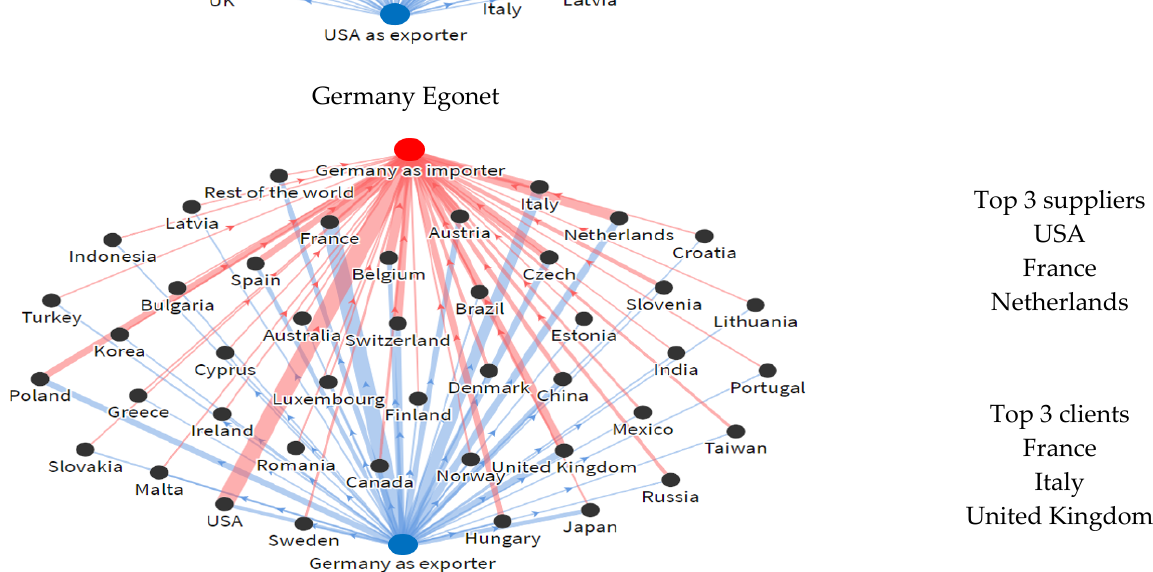
Figure 9. The egonets of Japan, the USA, and Germany in the Sectoral GVC network: “Manufacture of rubber and plastic products”.